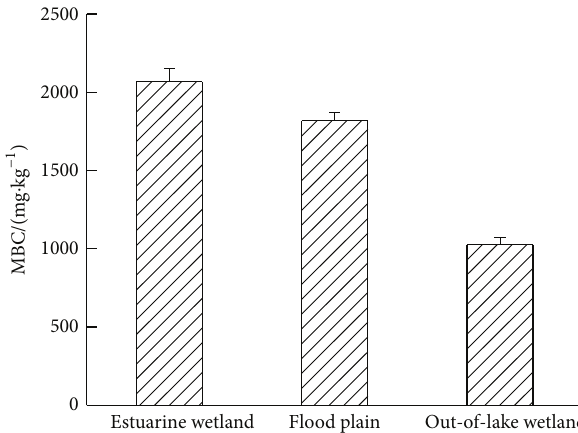
Figure 2: Changes of MBC content under different types of wetland in Hongze Lake of